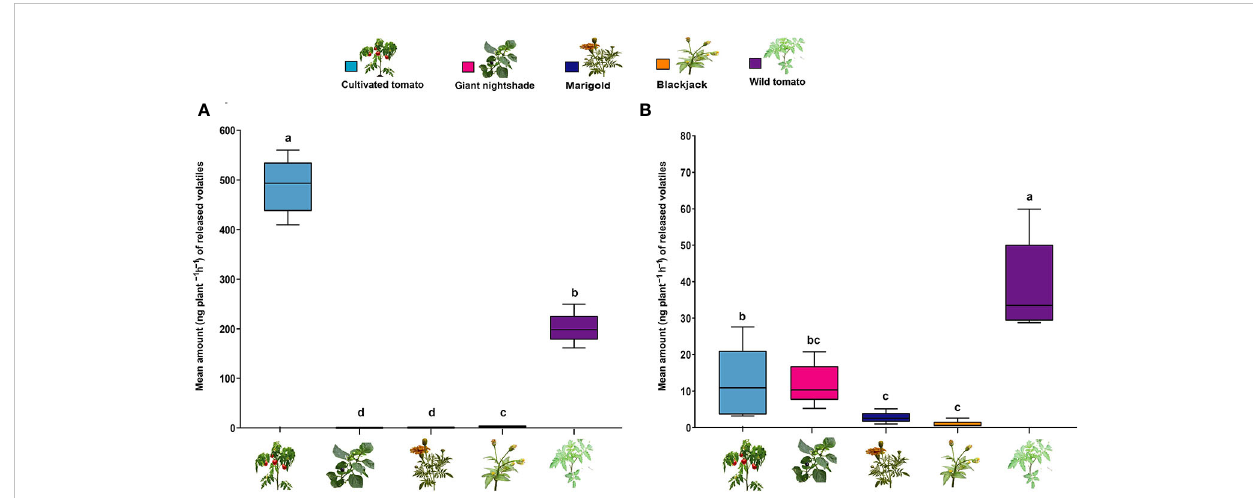
FIGURE 6 Mean concentration of volatile organic compounds (VOCs) detected from different host and non-plants. Box plot of VOCs from (A) most attractive six-component blend of the host plant monoterpenes comprising camphene, d -2-carene, a -phellandrene, a -terpinene, p-cymene, terpinolene and (B) most effective three-component non-host plant sesquiterpene blend comprising b -elemene, a -cedrene, a -humulene. Means with the same letter are not signi fi cantly different (Tukey ’ s HSD test, P ≤